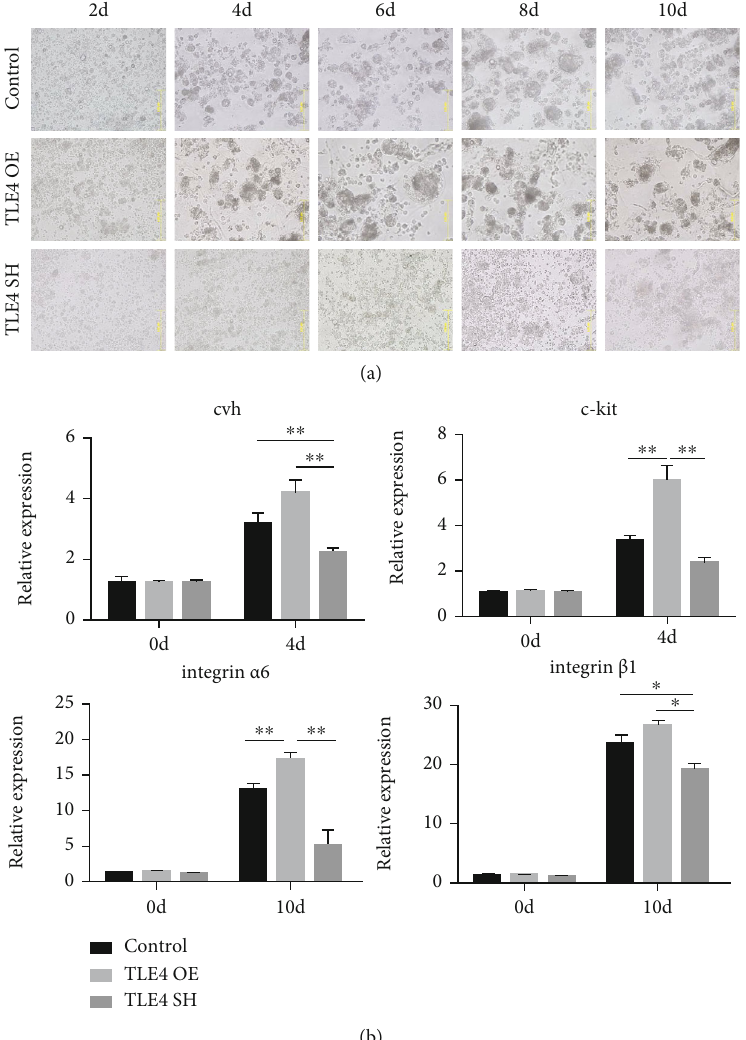
Figure 6: TLE4 function veri fi cation in vitro. (a) Cell morphology every two days; TLE4 OE: TLE4 overexpression; TLE4 SH: TLE4 suppression. (b) Marker genes were detected on day 4 and day